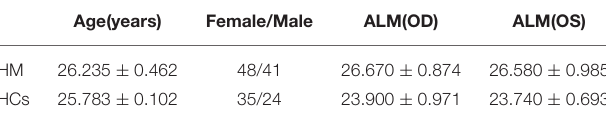
TABLE 1 | General characteristics of the